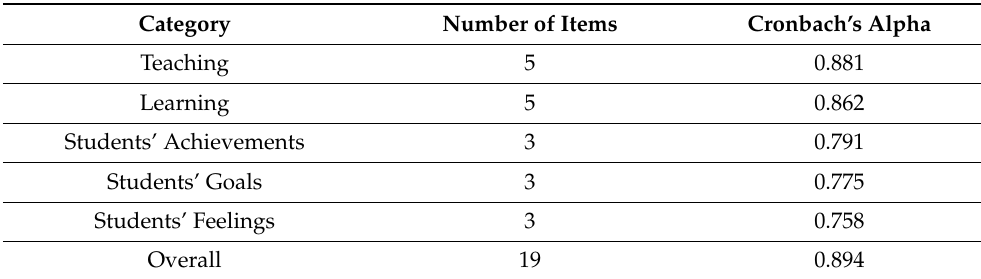
Table 3. Reliability value of questionnaire